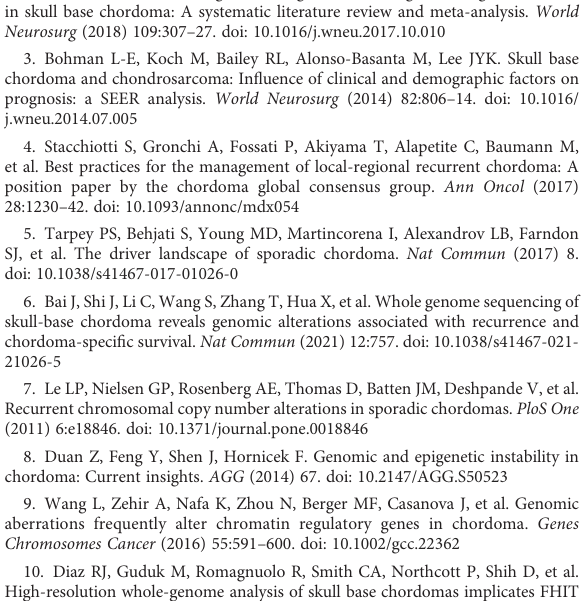
SUPPLEMENTARY TABLE 1 Differential supervised analysis of the gene expression, comparing control tumors and tumors treated with palbociclib for the responding CD3 PDX model. SUPPLEMENTARY TABLE 2 Differential supervised analysis of the gene expression, comparing control tumors and tumors treated with palbociclib for the non-responding CD7 PDX model. SUPPLEMENTARY TABLE 3 Differentialsupervisedanalysis ofthegeneexpression ofcontrolCD3PDX tumors and control CD7 PDX tumors